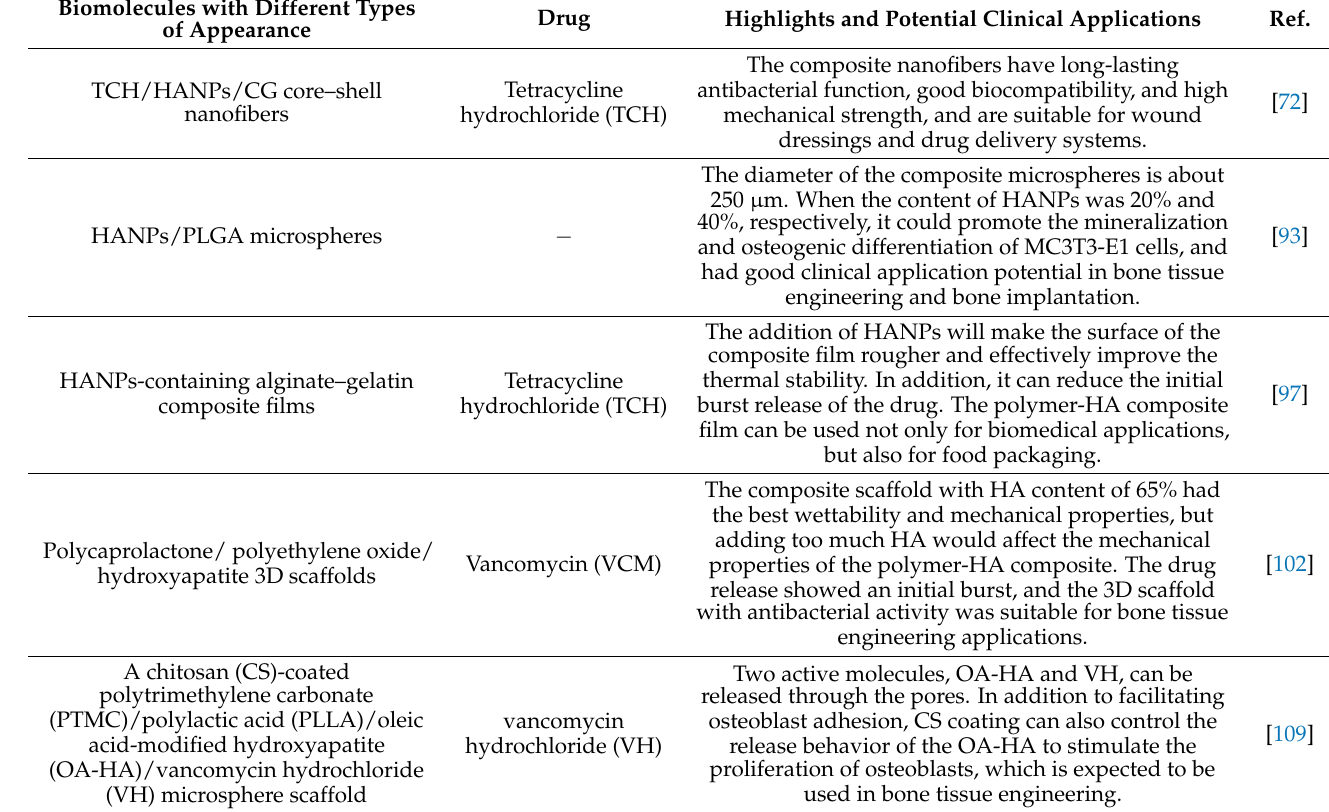
Table 2. Characteristics and possible clinical applications of different types of polymer-HA